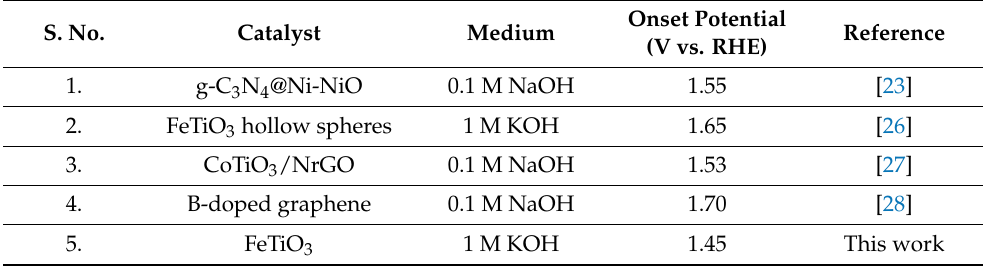
Table 1. Comparison of onset potential of various catalysts for OER.